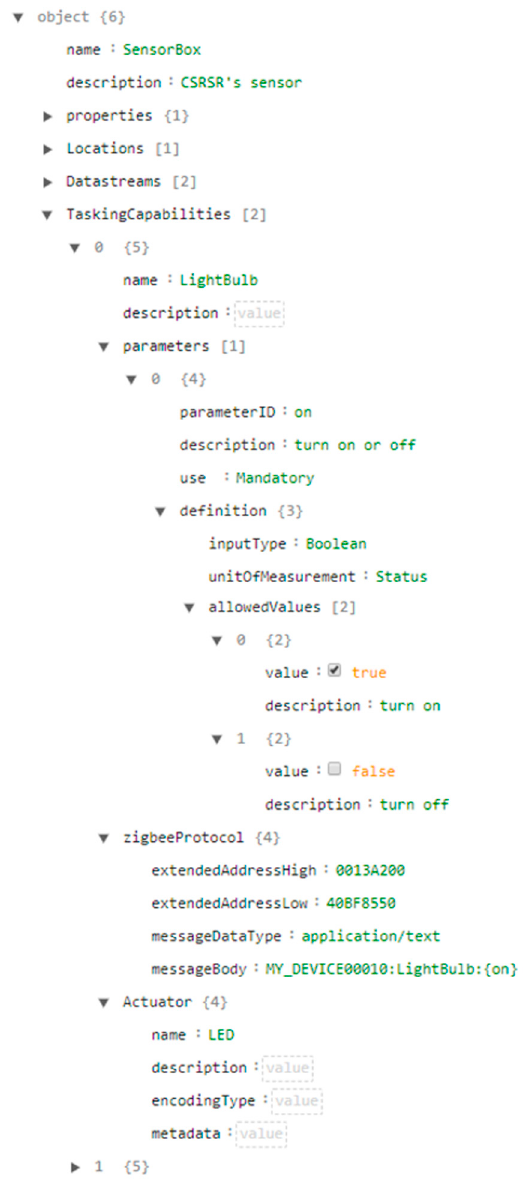
Figure 6. Tasking capability of an example description file.